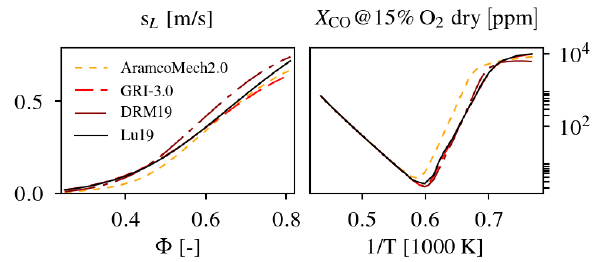
Figure 1. Laminar flame speed in dependency of equivalence ratio ( left ) and dry and corrected carbon monoxide mole fractions over adiabatic flame temperature ( right ) for different reaction mechanisms at gas turbine part load